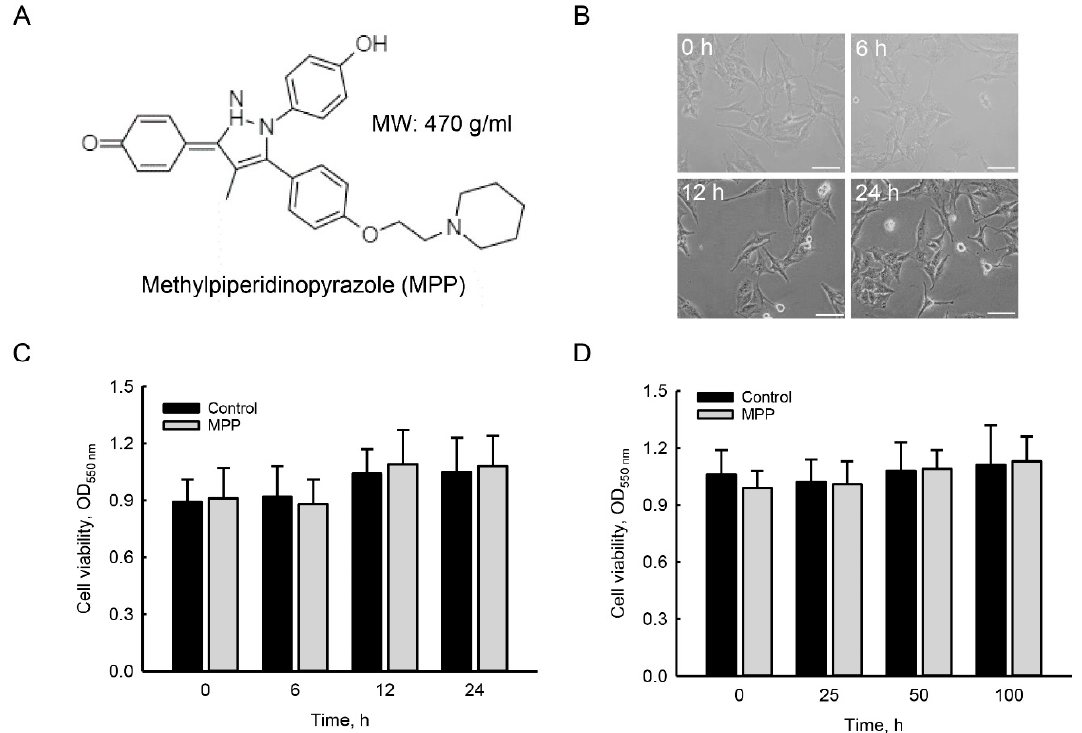
Figure 1. Methylpiperidinopyrazole (MPP) did not a ff ect the morphology or survival of rat calvarial osteoblasts. The chemical structure and molecular weight (MW) of MPP are shown ( A ). Primary osteoblasts isolated from neonatal rat calvarias were exposed to 100 µ M MPP for 6, 12, and 24 h. Cell morphology was observed and photographed using an inverted light microscope ( B ). In addition, rat calvarial osteoblasts were treated with 100 µ M MPP for 6, 12, and 24 h or with 25, 50, and 100 µ M MPP for 24 h. Survival of primary rat osteoblasts was analyzed using a trypan blue exclusion method ( C and D ). Each value represents the mean ± standard deviation of at least three independent determinations. Scale bar: ― 50 μ M.